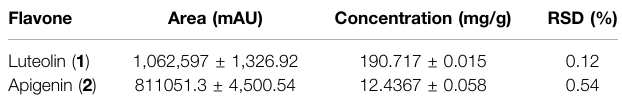
TABLE 2 | Quanti fi cation of luteolin and apigenin (mg/g dry extract) content in the fl avone-rich fraction of Arrabidea chica Verlot. Flavone Area (mAU) Luteolin ( 1 )